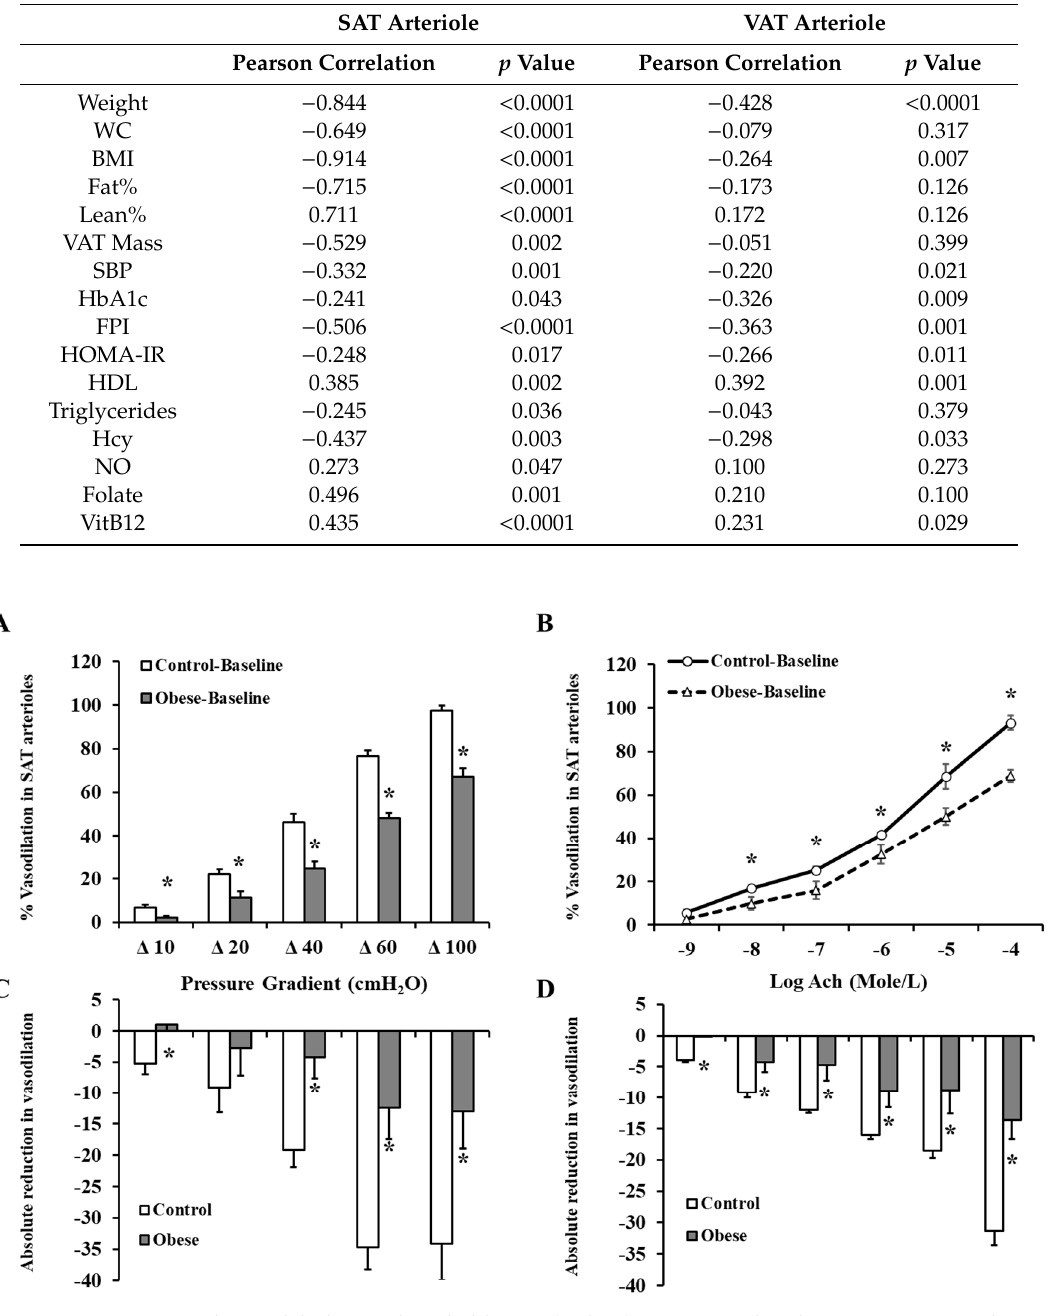
Figure 3. FID and acetylcholine-induced dilation (AchID) in SAT isolated resistance arterioles. FID measurements in SAT arterioles isolated from obese ( n = 40) and non-obese ( n = 40) subjects corresponding to increasing intraluminal pressure gradients of 10–100 cmH 2 O ( A ). AchID measurements in SAT arterioles corresponding to increasing concentrations of Ach (10 − 9 to 10 − 4 M) ( B ). Absolute reduction in FID in response to eNOS inhibition via L-NAME (10 − 4 M) ( C ). Absolute reduction in AchID in response to eNOS inhibition via L-NAME ( D ). All measurements are presented as means ± standard error (SE). * ( p < 0.05) for comparing obese subjects with controls.